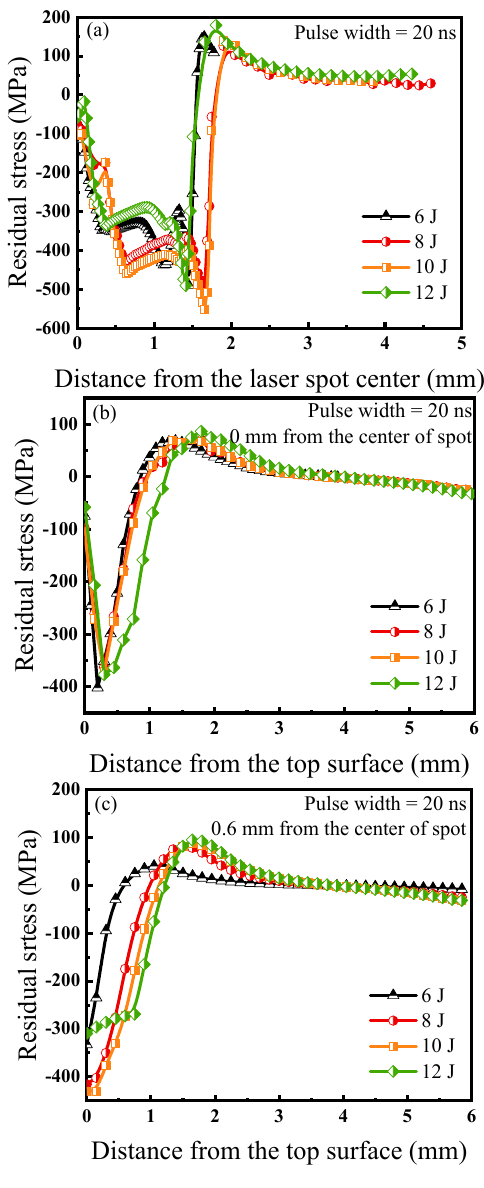
Figure 8. Residual stress distribution of specimens with different pulse energies ( a ) Pulse width 20 ns: surface residual stress ( b ) Pulse width 20 ns: residual stress in the depth direction of the spot center ( c ) Pulse width 20 ns: residual stress at a depth of 0.6 mm from the spot center.